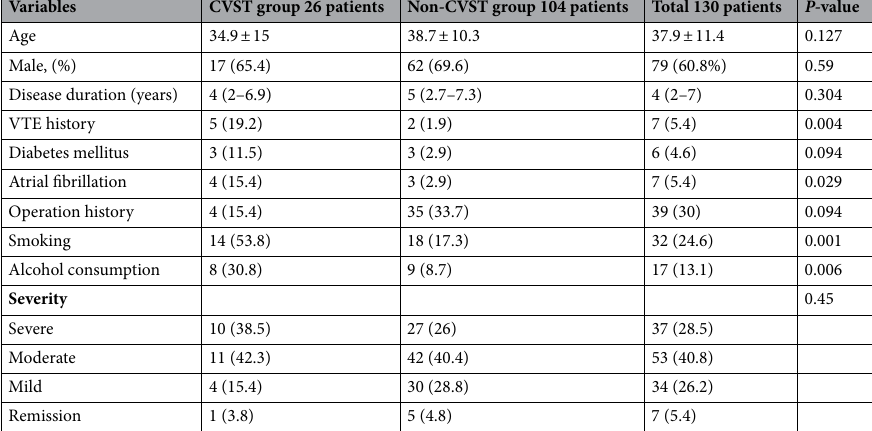
Table 1. Demographic data of IBD patients. Values are presented as number (%). VTE, venous thromboembolism.